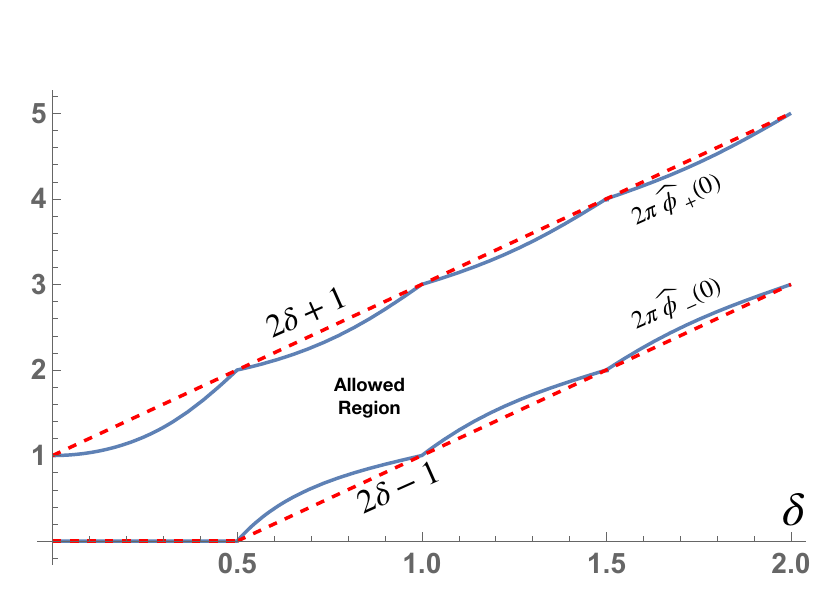
Figure 3: The solid blue lines are the optimal values (83,84) of 2 π (cid:210) φ ± ( 0 ) as func- tions of δ